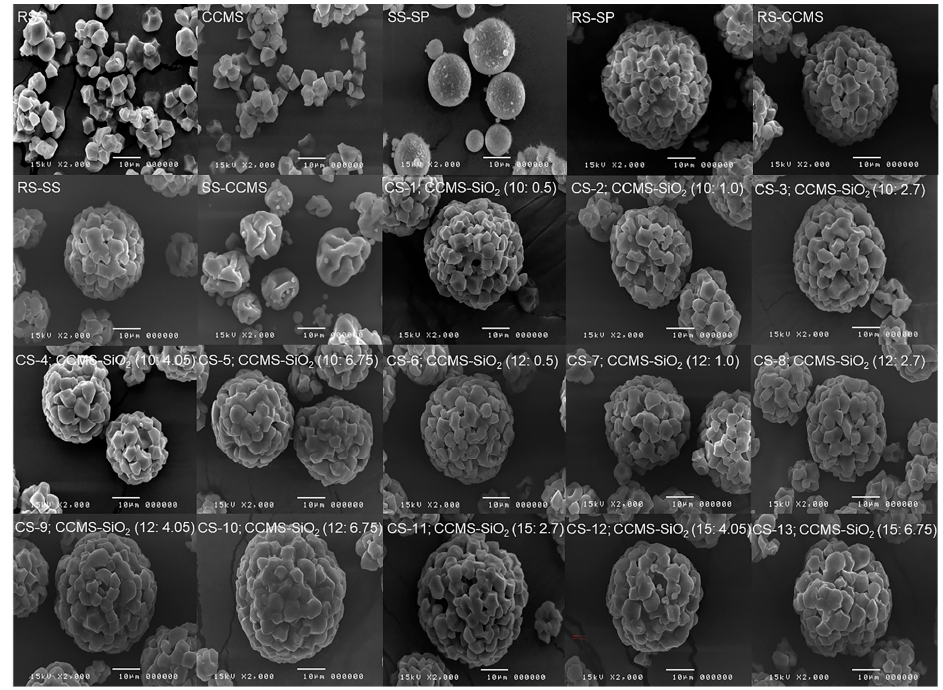
Figure 4. SEM images of RS, CCMS, SS - SP, RS - SP, RS - CCMS, RS - SS, SS - CCMS, and CSs with different CCMS (10%, 12%, 15%) and SiO 2 (0.5%, 1.0%, 2.7%, 4.05%, 6.75%) levels.